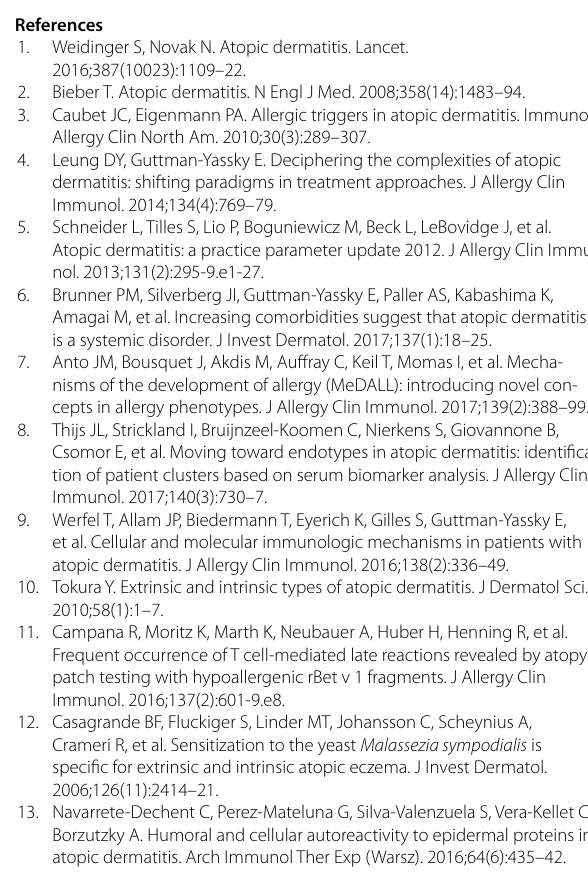
Additional file 1. Supplementary Methods, Table S1, Table S2, Table S3 and Fig S1. Abbreviations AD: atopic dermatitis; AMPs: antimicrobial peptides and proteins; HC: healthy controls; His6-ABP: N-terminal hexa-histidine albumin binding protein;